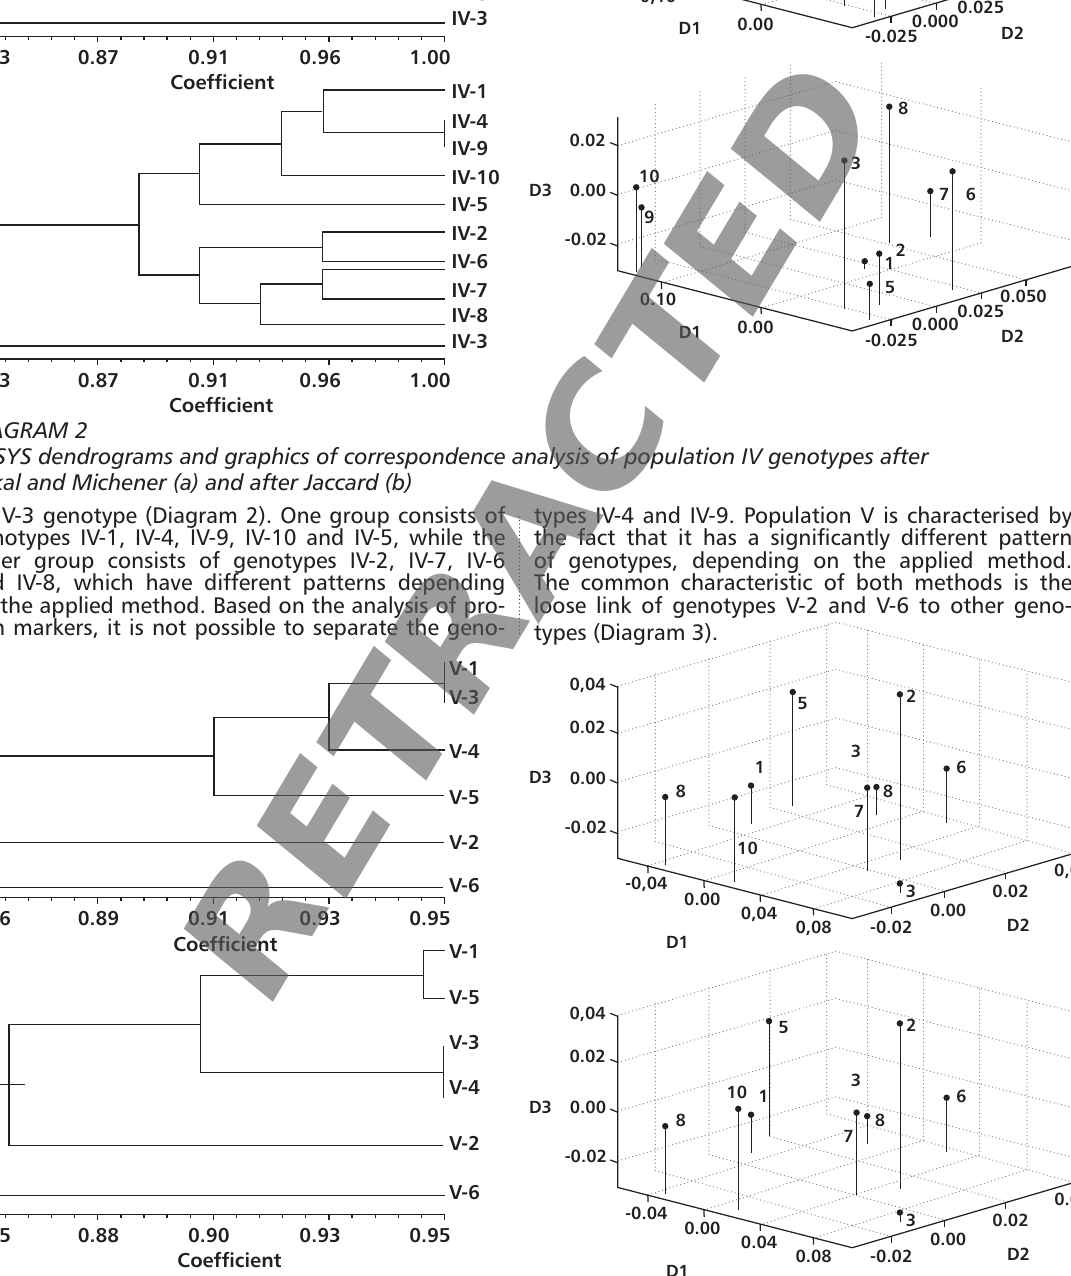
DIAGRAM 3 NTSYS dendrograms and graphics of correspondence analysis of population V after Sokal and Michener and after